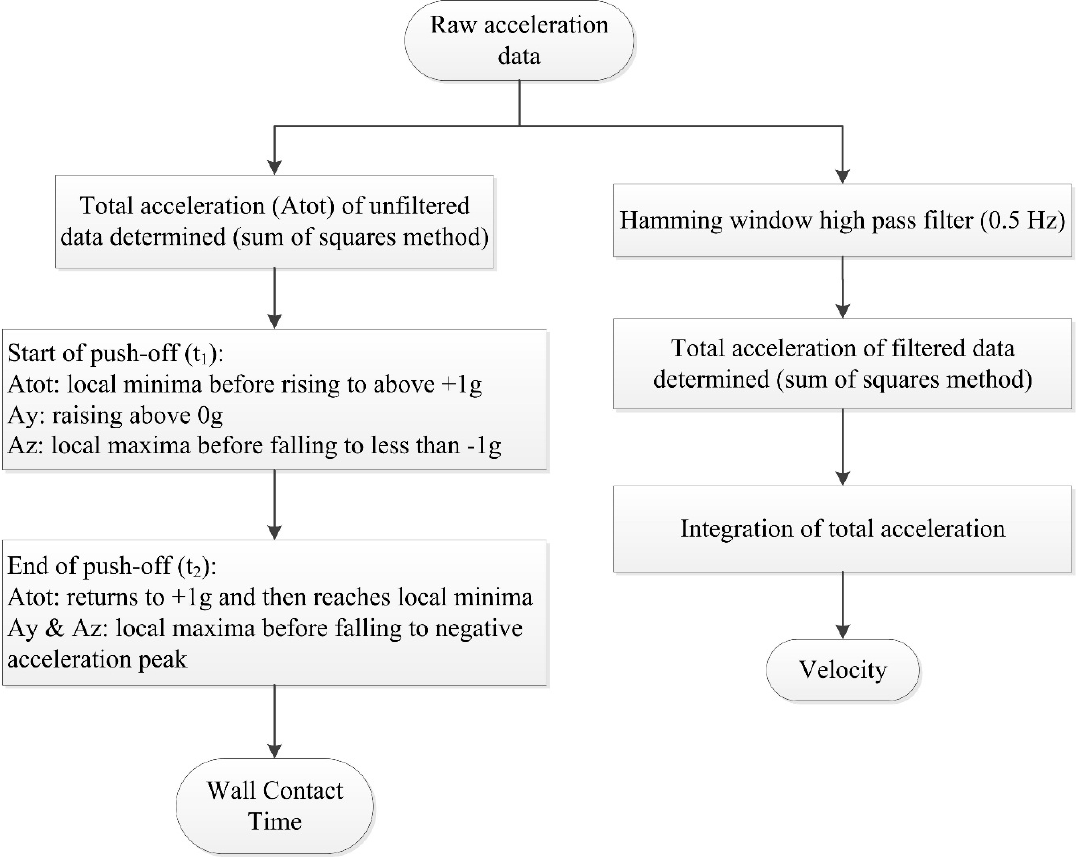
Figure 28. Method of determination of push-off velocity and wall contact time that utilizes all three acceleration signals and the resultant total acceleration. The raw unfiltered signal output is used to automatically determine the start and end of wall contact whilst the filtered signal was used to determine velocity during the push off phase. Adapted from Stamm, James, Burkett, Hagem and Thiel [82].